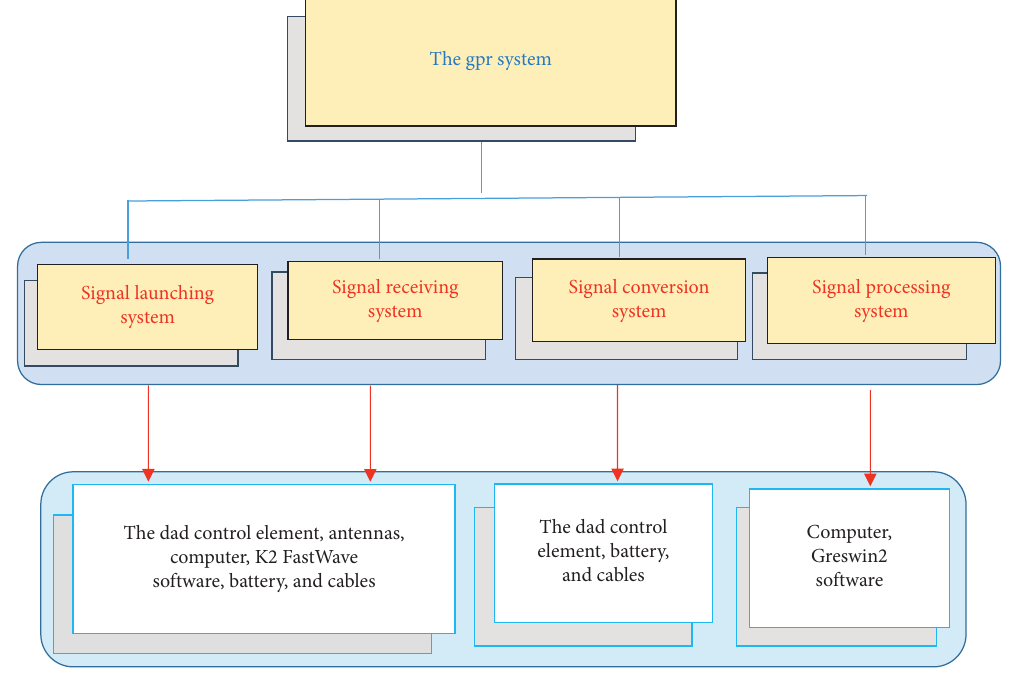
Figure 4: The GPR system.